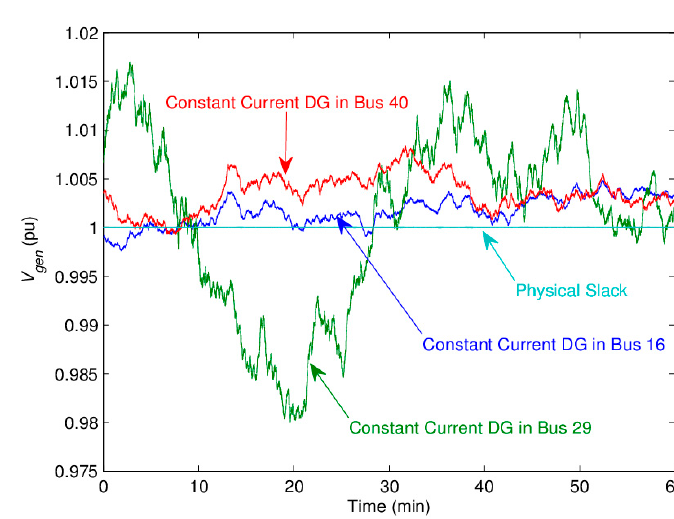
Figure 9. Voltages of physical slack and constant current controlled DGs.